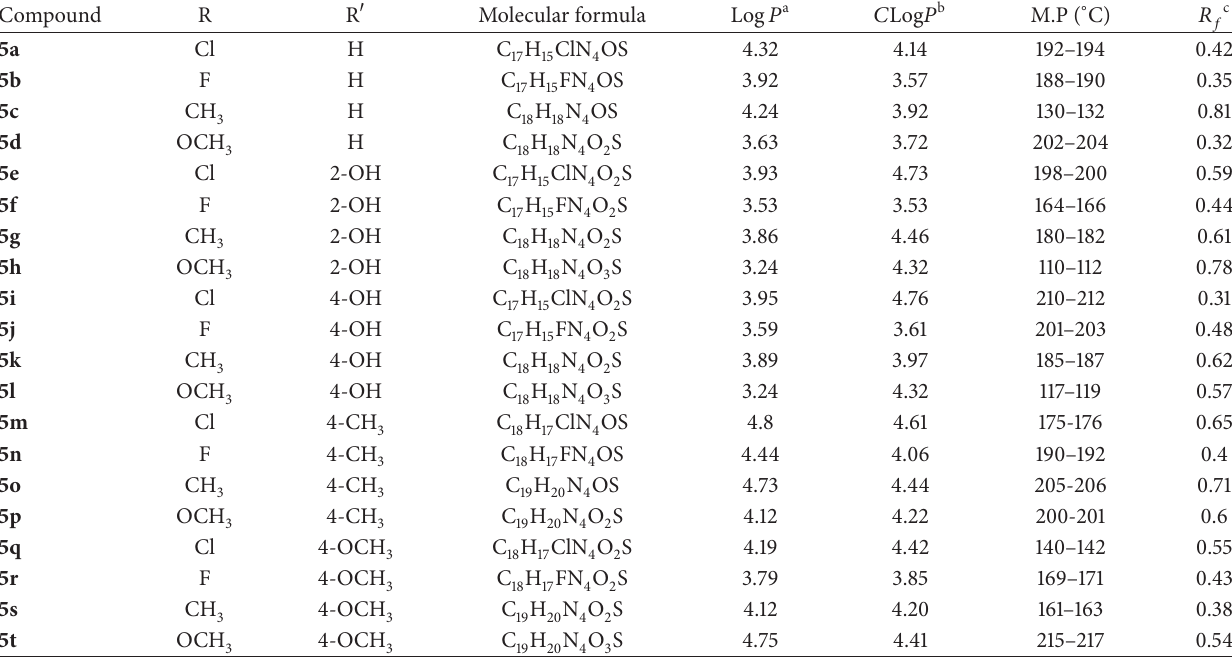
Table 1: Physicochemical parameters of the synthesized compounds ( 5a – t